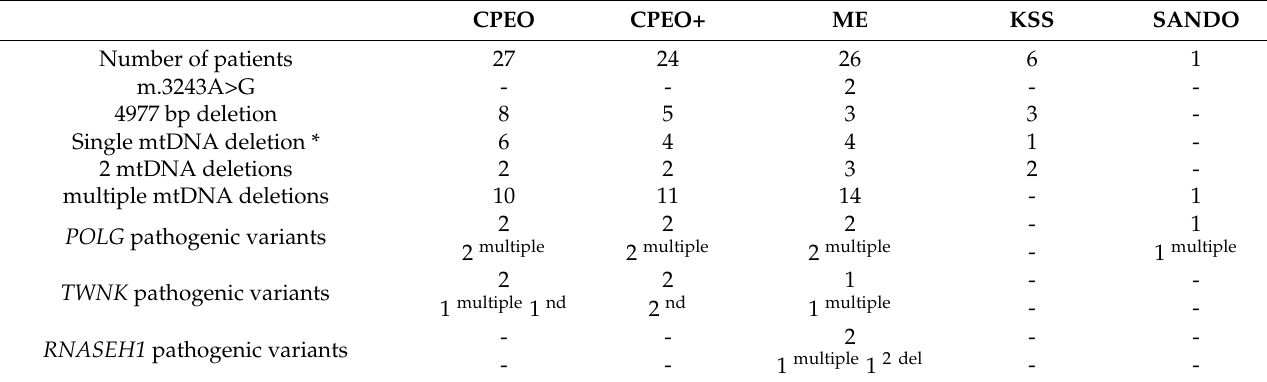
Table 2. Genetic results in patients with progressive external